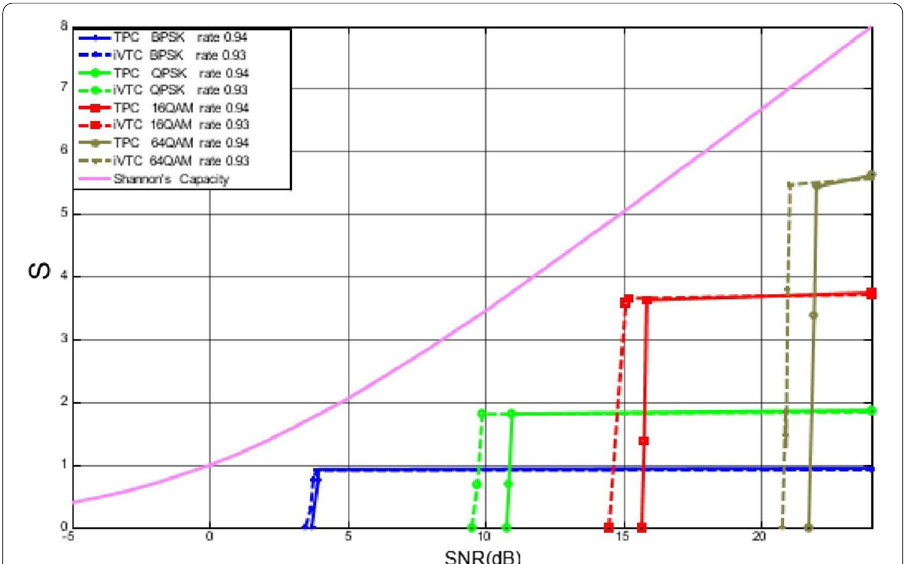
Fig. 9 (255,247)TPC and equivalent iVTC throughput per channel use versus SNR. S represents bits/channel use